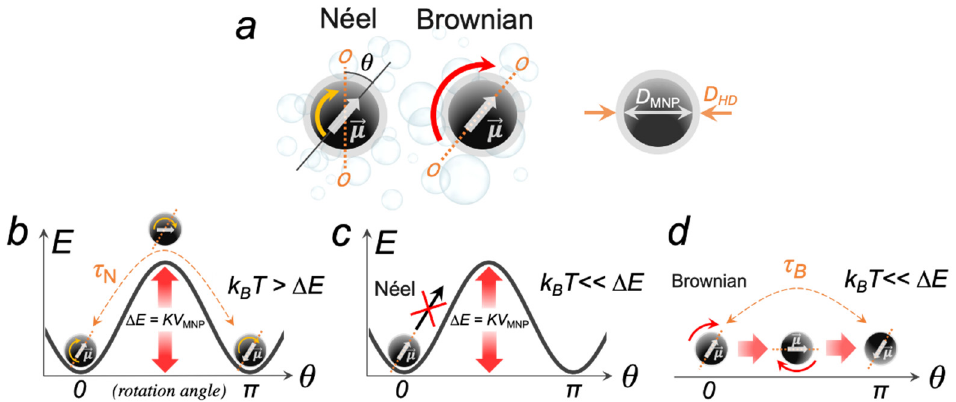
Figure 2. Schematic representation of the dynamic behavior of the MNP magnetic moment 𝜇⃗ in the absence of an external MF; ( a ) Néel and Brownian relaxation mechanisms, where θ is the angle between the MNP magnetic moment 𝜇⃗ and the easy axis of magnetization O-O ; D MNP and D HD are the core and the hydrodynamic diameters of an MNP; ( b ) Néel relaxation in a zero field when k B T >> KV MNP ; ( c ) Néel relaxation is forbidden if the MNP is physically unable to move and k B T << KV MNP ; ( d ) Brownian relaxation becomes possible if an MNP is suspended in a fluid.